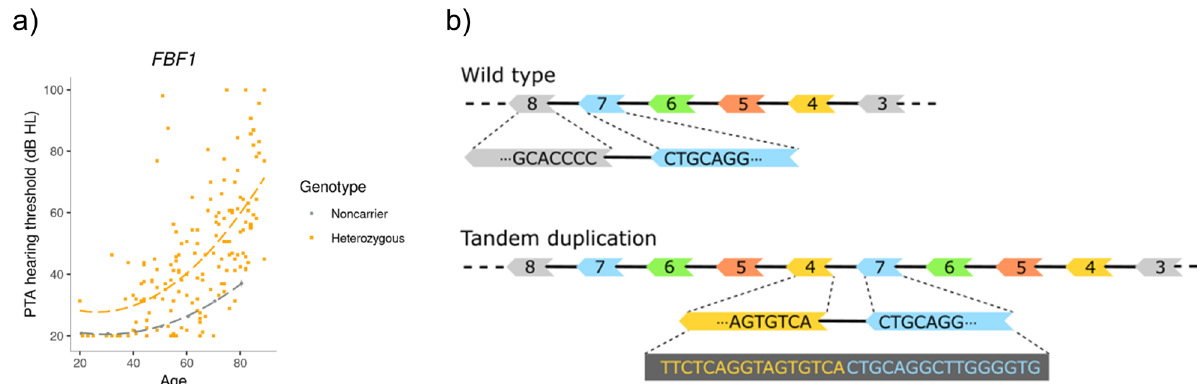
Fig. 3 A tandem duplication in FBF1 associates with ARHI. a ) The PTA hearing threshold of the heterozygous carriers (N = 166) of the tandem duplication in FBF1 in DHS and NIHSI datasets are indicated by yellow squares and the average PTA hearing thresholds of non-carriers in the DHS dataset ( N = 11,484) are represented with gray dots. The corresponding dashed lines are polynomial regression lines of best fi t. The gray vertical lines represent 95% con fi dence intervals. b ) The exon structure of the wild type and the tandem duplication variant in transcript ENST00000586717.5 of FBF1 on the reverse strand of chromosome 17. The exons of the transcripts are numbered, and solid black lines represent splicing between exons. The tandem duplication creates a longer transcript with extra sets of exons 4 – 7 that leads to novel splice junction starting at the end of exon 7 and splicing into the beginning of exon 4. The adjacent sequences of the exons are shown, and together they form the 32 bp sequence used for identi fi cation of the novel Table 7). Variants in CTBP2, CRIP3 , AGO2, PHLDB1 , LMX1A ,